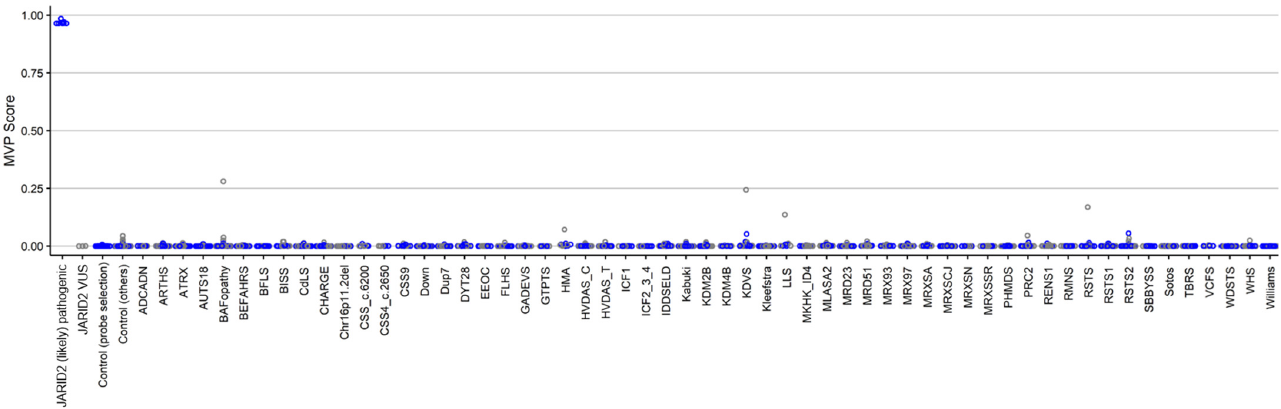
Figure 5. MVP scores generated by the support vector machine (SVM) classification model. All of the case samples ( JARID2 (likely) pathogenic) received high MVP scores, in contrast to the control samples and individuals from all the other disorders that received low scores, indicating the full specificity of the model. The three samples with JARID2 VUSs yielded scores near zero.